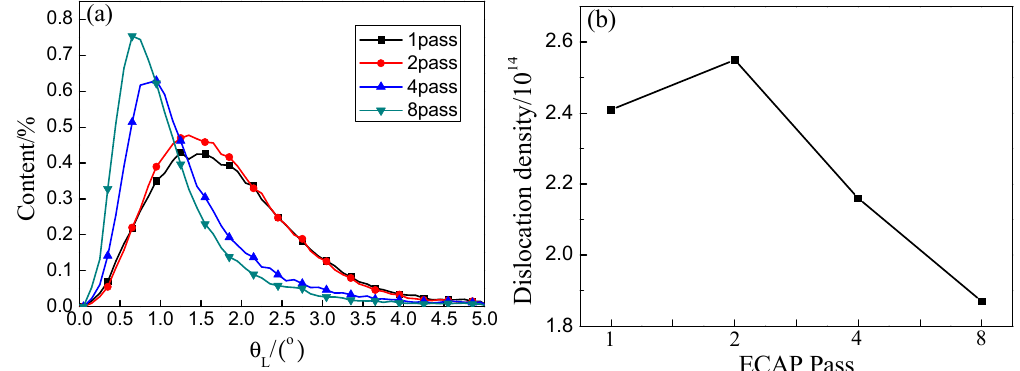
Figure 3. Distribution curve of local orientation di ff erence and dislocation density under di ff erent deformation passes in aged Cu–1Cr–0.2Si alloy. ( a ) Local orientation di ff erence distribution. ( b ) Dislocation